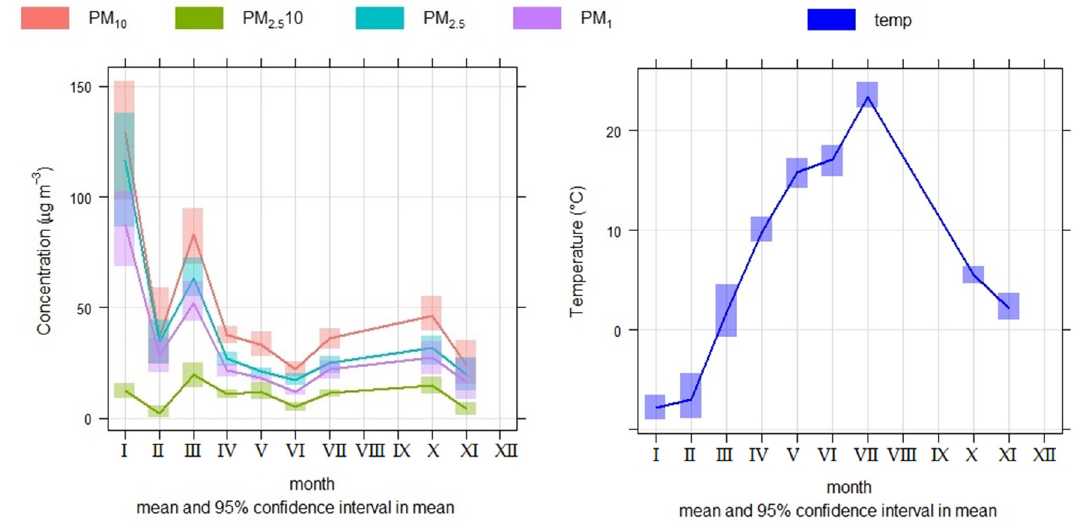
Figure 2. Seasonal variation in PM evaluated from measurements in the city of Žilina.